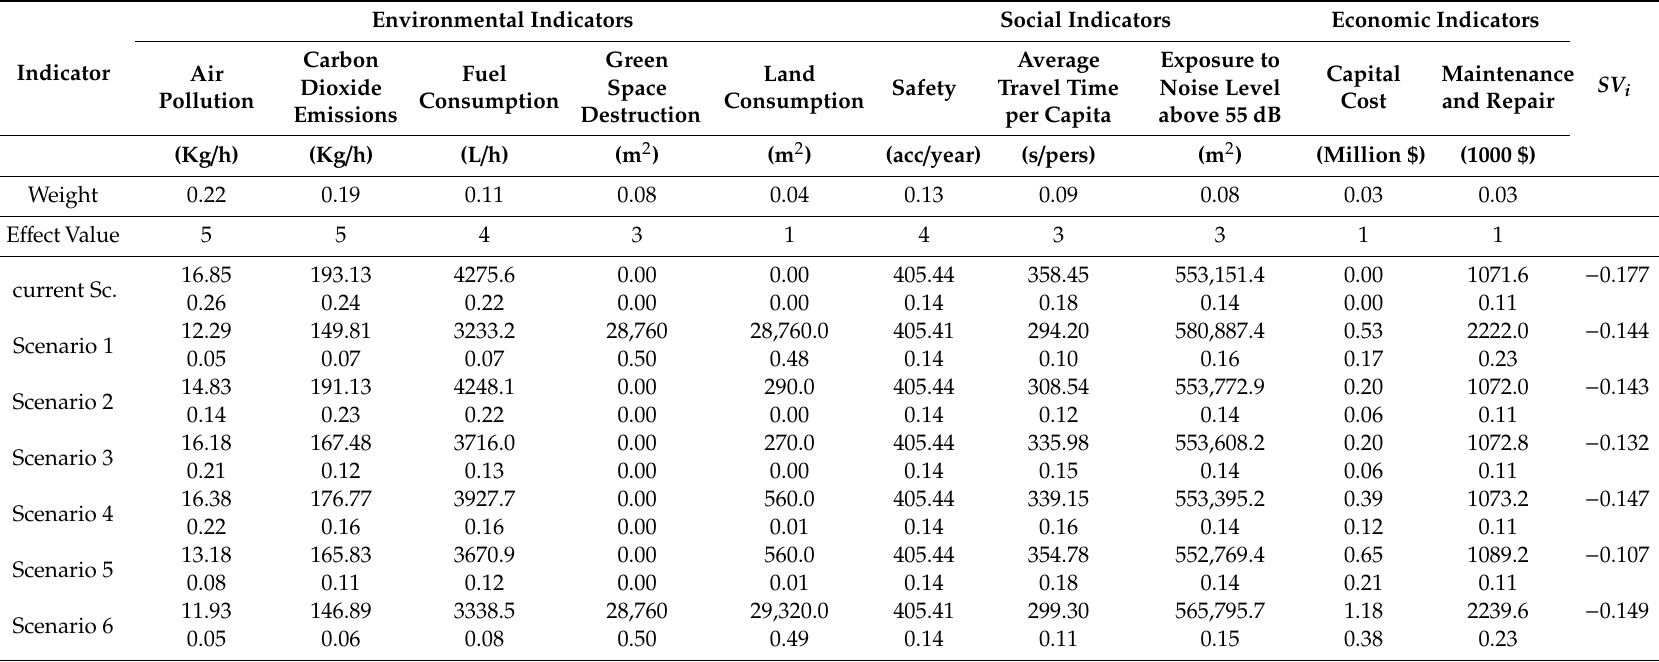
Table 5. Values of indicators and applied e ff ect of changes intensity in each indicator (AECIEI)